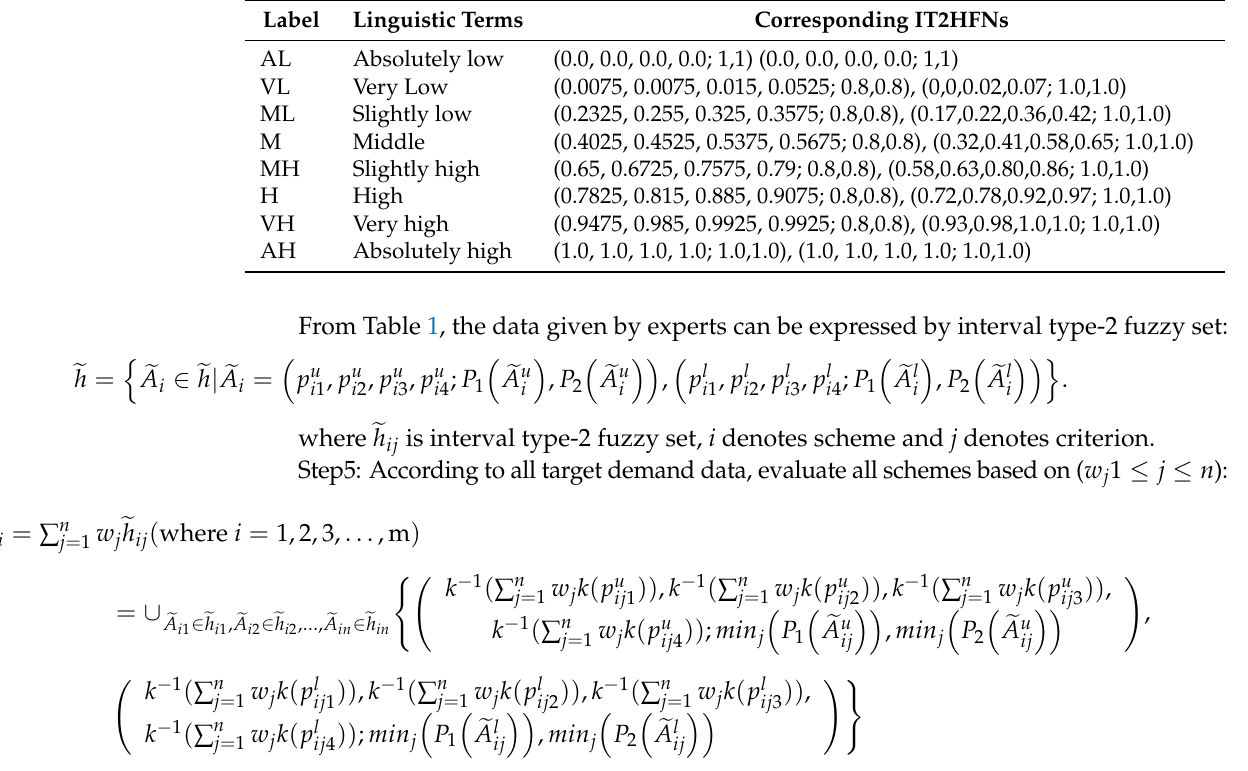
Table 1. Linguistic term set and their corresponding values.